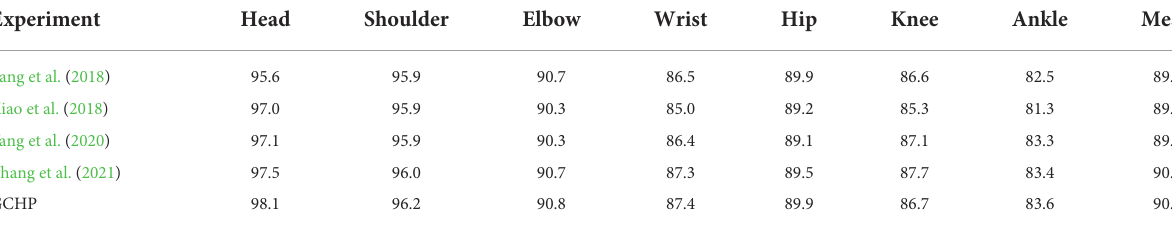
TABLE 1 Experimental results on the MPII dataset.